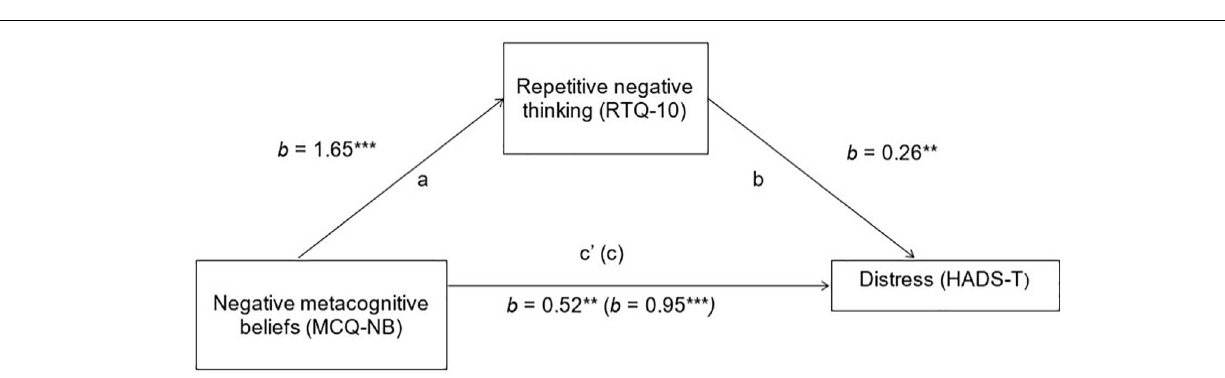
FIGURE 3 | Mediation of negative metacognitive beliefs on emotional distress, via Repetitive Negative Thinking. HADS-T, total adapted Hospital Anxiety and Depression Scale score; MCQ-NB, Metacognitions Questionnaire-30 negative beliefs about worry subscale; RTQ-10, Repetitive Thinking Questionnaire. * p < 0.05, ** p < 0.01, and *** p <